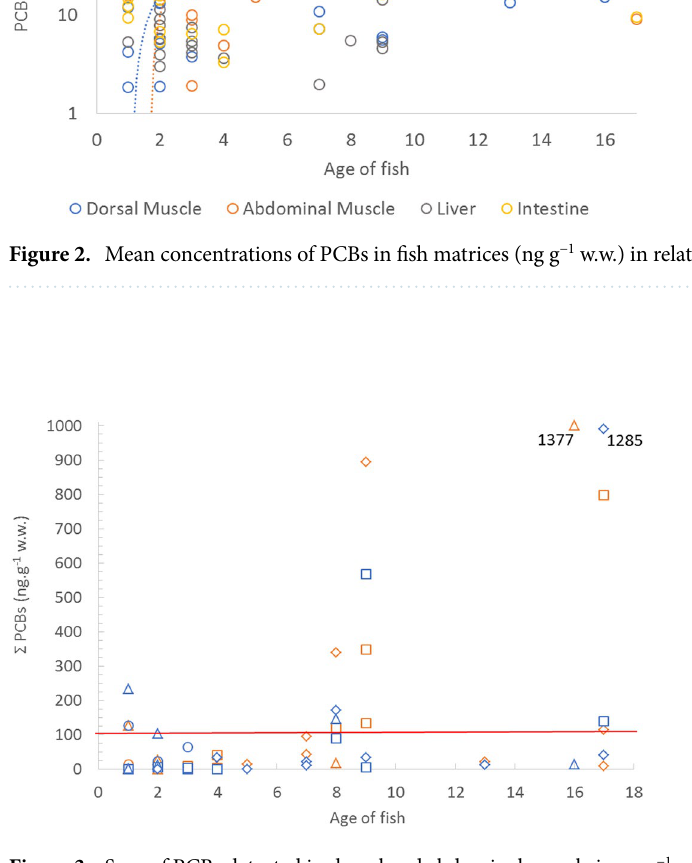
Figure 3. Sum of PCBs detected in dorsal and abdominal muscle in ng g −1 w.w in relation to age of fish (N = 30). Plus point (+) for age 16, resp. 17 represents value 1377, resp. 1285. Red line represents maximum permissible value of sum of PCB in fish meat in wet weigt (limit is ng g −1